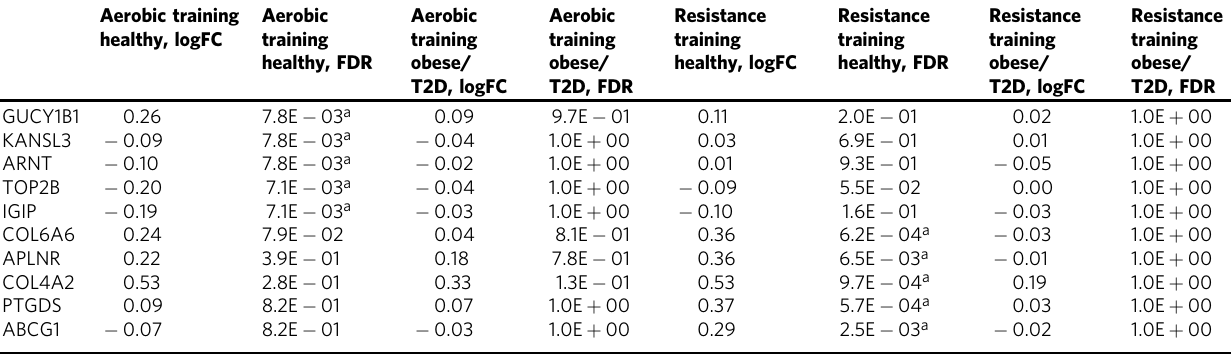
Table 4 Genes non-responsive to exercise in metabolically impaired